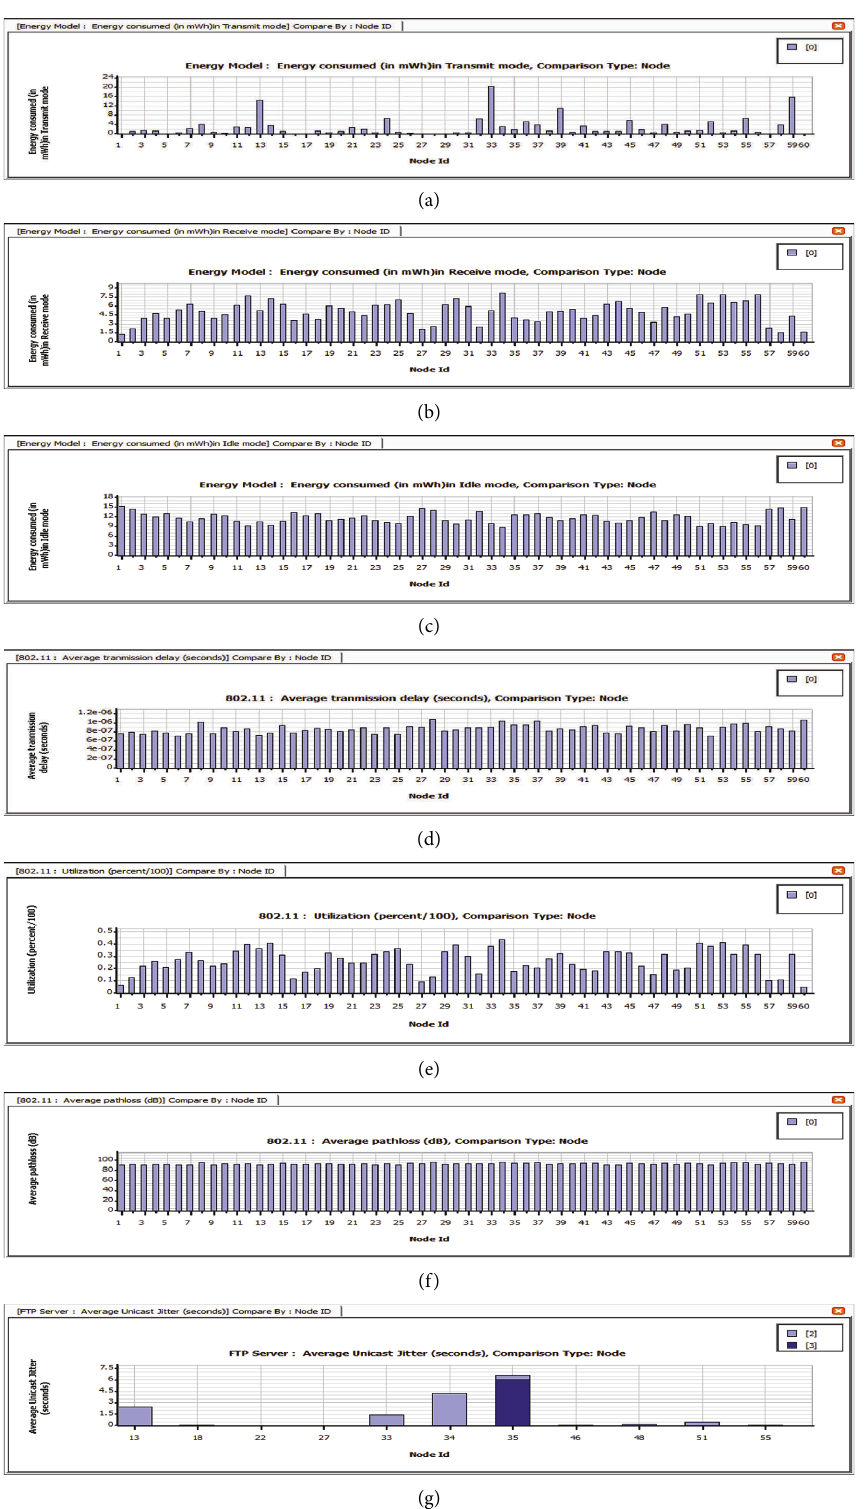
Figure 13: (a) Transmit mode energy consumption of BELLMAN FORD for FTP deployment. (b) Receive mode energy consumption of BELLMAN FORD for FTP deployment. (c) Idle mode energy consumption of BELLMAN FORD for FTP deployment. (d) Average transmission delay of BELLMAN FORD for FTP deployment. (e) Percentage of utilization of BELLMAN FORD for FTP deployment. (f) Average pathloss of BELLMAN FORD for FTP deployment. (g) Average jitter of BELLMAN FORD for FTP